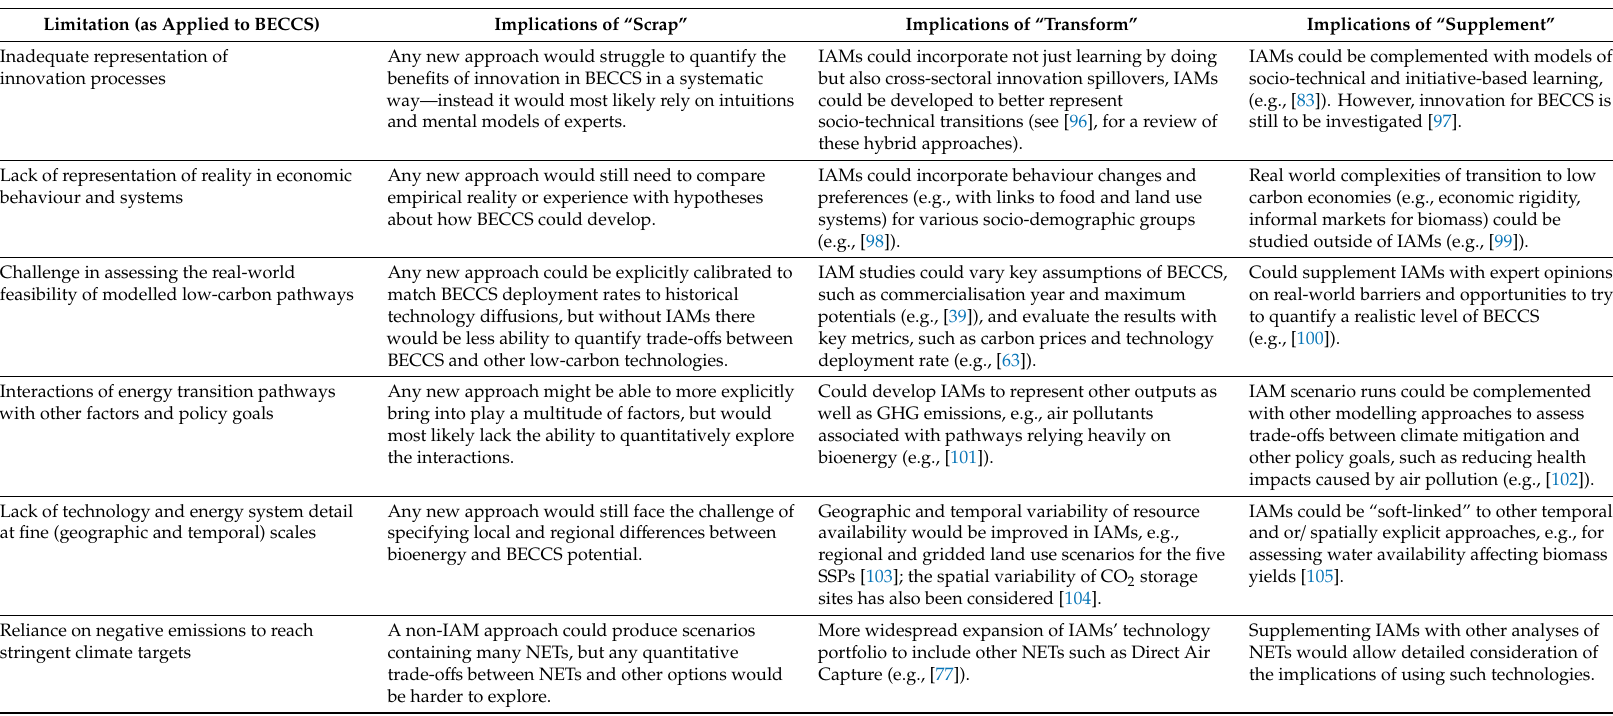
Table 3. Implications of suggested approaches on the model design and representation of BECCS in low-carbon